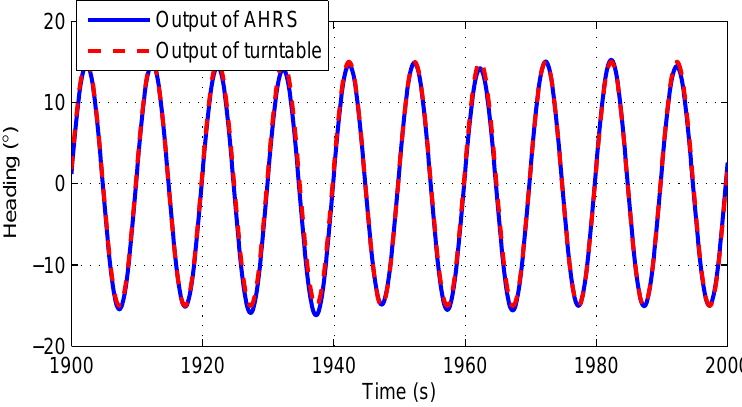
Figure 13. Attitude and heading errors of experiment